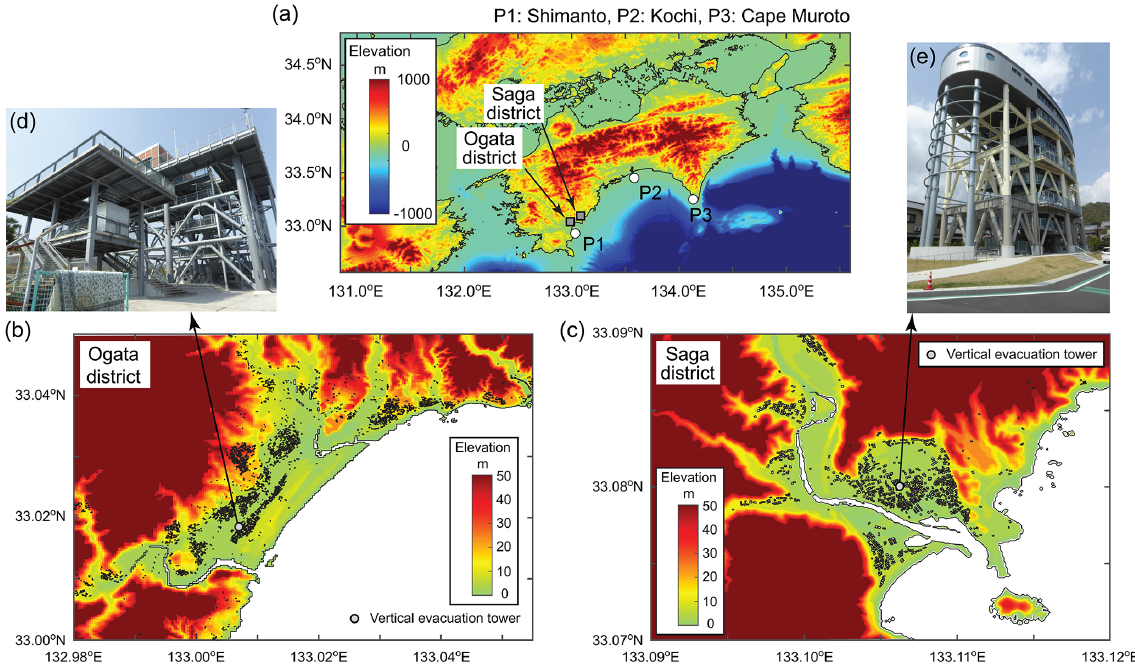
Figure 4. Elevation maps of (a) Shikoku Island, (b) Ogata district, and (c) Saga district. In (b) and (c) , the locations of residential buildings are shown as polygons. The photos in (d) and (e) are the vertical evacuation towers in the Ogata and Saga districts. The Ogata and Saga districts are located in Kuroshio, Kochi Prefecture. The locations of Kuroshio and Kochi Prefecture are indicated in Fig.